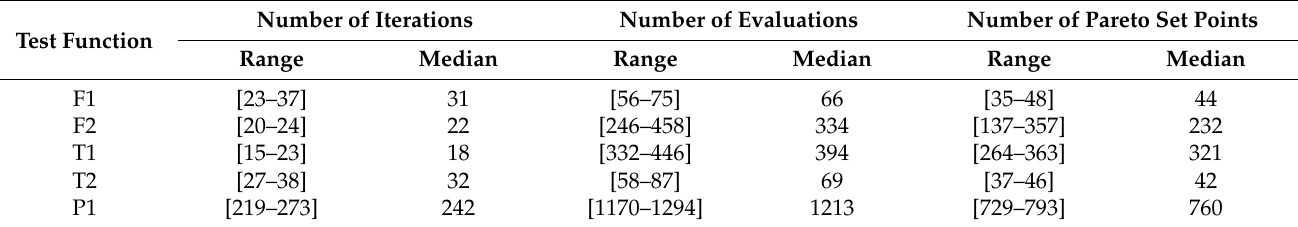
Table 3. Summary of test results of AMSP.